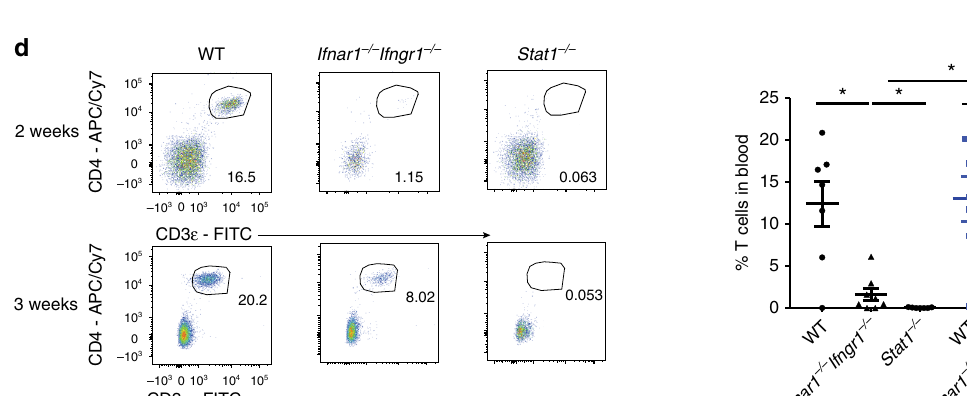
Stat1 − / − T cells in vivo was not analyzed and STAT1 was assumed to act in a similar fashion as T-bet 13 . We observe that in our model of colitis 17 , STAT1 modulates the disease outcome primarily by promoting T-cell survival rather than altering differentiation, as Stat1 − / − T cells displayed